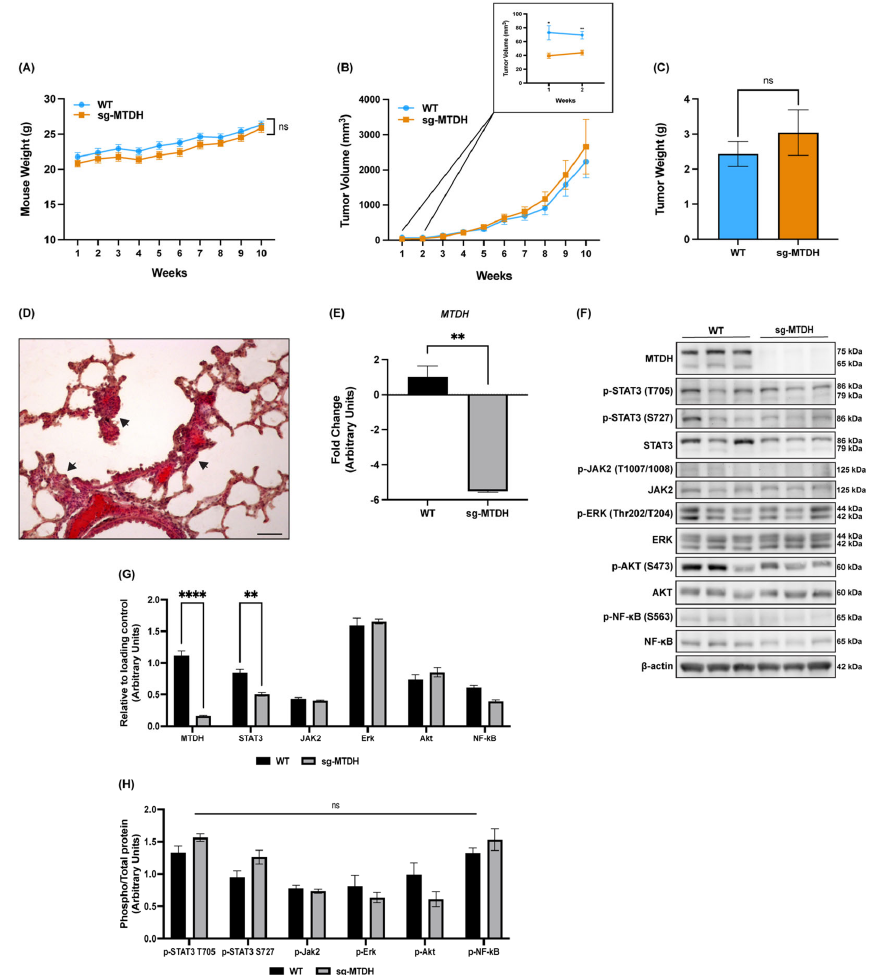
Figure 6. MTDH knockout delayed tumor development, reduced lung metastasis, and decreased STAT3 expression in a SUM ‐ 149 xenograft model. Xenograft IBC models were generated by inject ‐